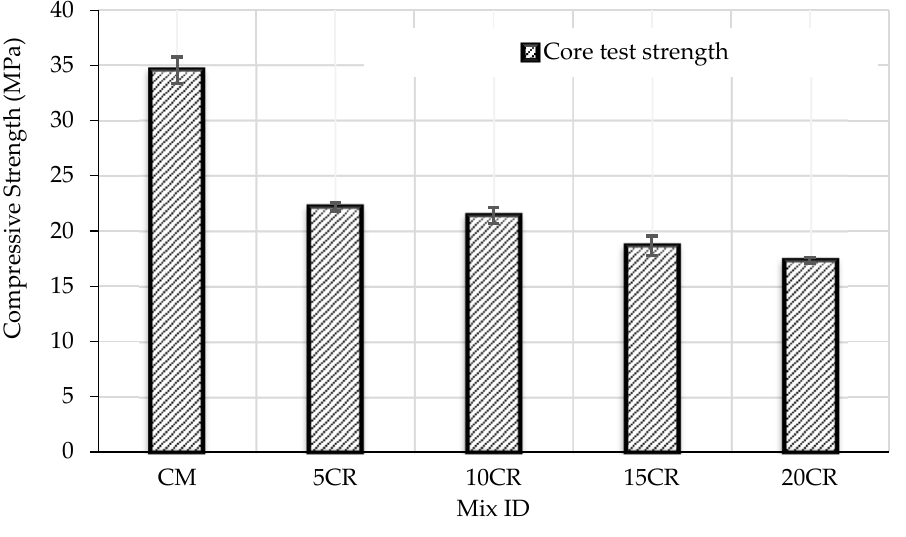
Figure 17. Compressive strength for core samples.